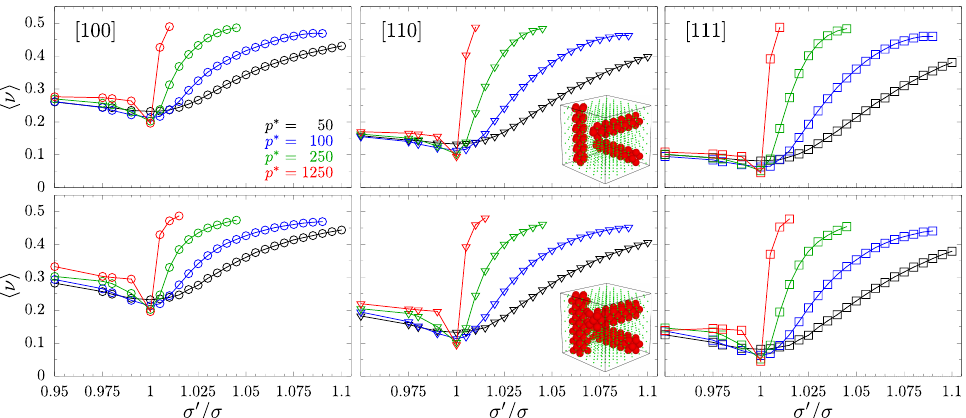
Figure 8. PR for selected (cid:126) n -directions, indicated in the top left of their respective columns, averaged over all possible (cid:126) m -directions. Different symbols (circles, triangles, and squares) correspond to PR in the direction [ 100 ] , [ 110 ] , and [ 111 ] , respectively. The figure contains data for models with separate nanochannels. Plots for the respective size of the nanochannel have been arranged in rows, as indicated by the miniature structure inserts. The values of the reduced external pressure p ∗ have been indicated in